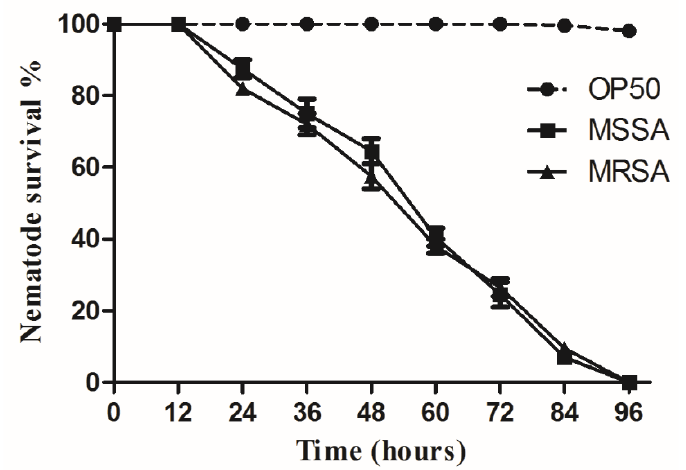
Figure 2. The survival of Caenorhabditis elegans ( C. elegans ) assessed by liquid-based assay. Staphylococcus aureus strain ATCC25923 (MSSA) and Staphylococcus aureus strain ATCC33591 (MRSA) were compared to Escherichia coli (OP50) as a control group.